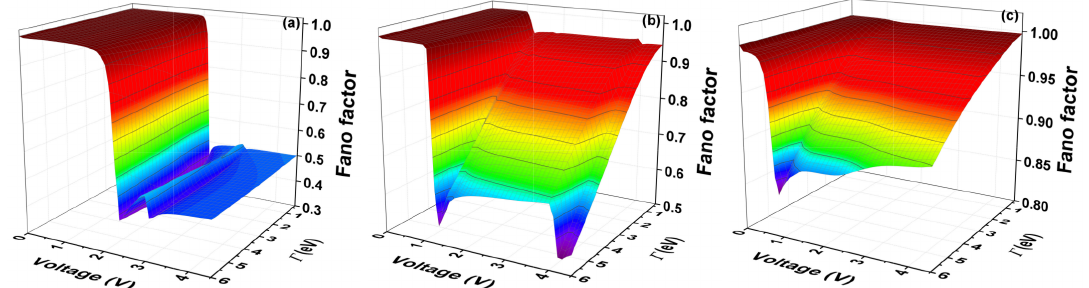
Figure 9. (color online) Fano factor ( F ) as a function of bias voltage and the molecule–electrode coupling ( Γ ) for the molecular system with thiophene rings with ( a ) one ring ( b ); two rings ( c ); and three rings for E c = − 5.54 eV, E s = 0.98 eV, t d = t δ = t c = − 2.40 eV, and t τ = t s = − 0.83